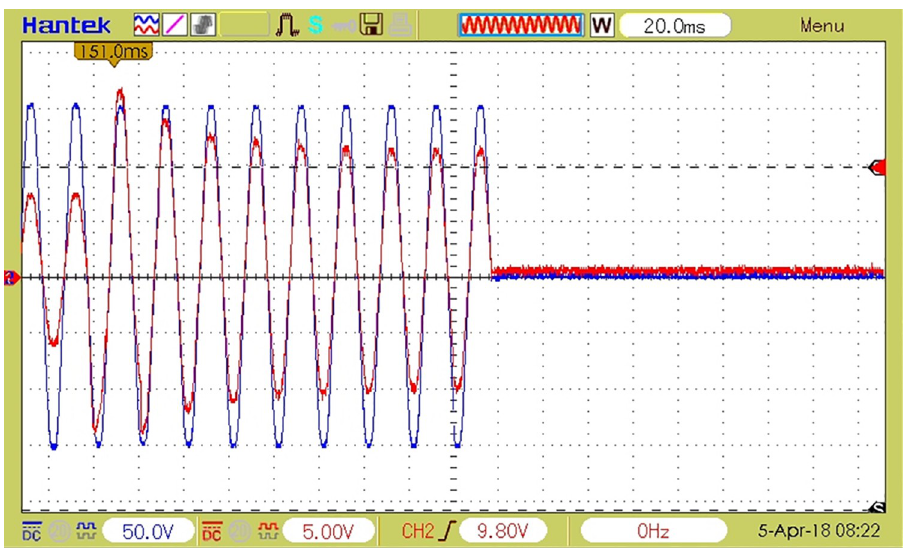
Fig 8. The waveforms of load current and voltage at coupling an additional R load causing the decoupling in 10 periods—200ms (in the event of a 20% overload).